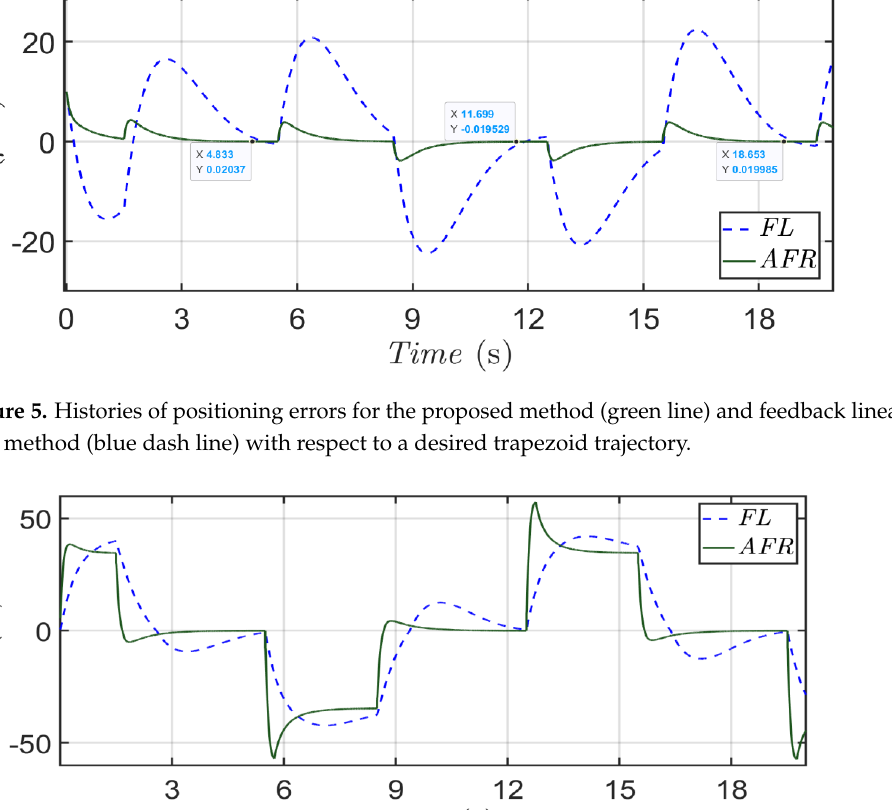
Figure 4. Micro-positioning results of output displacement z based on the proposed method (green line) and feedback linearization method (blue dash line) with respect to a desired trapezoid trajec- tory (red dotted line).